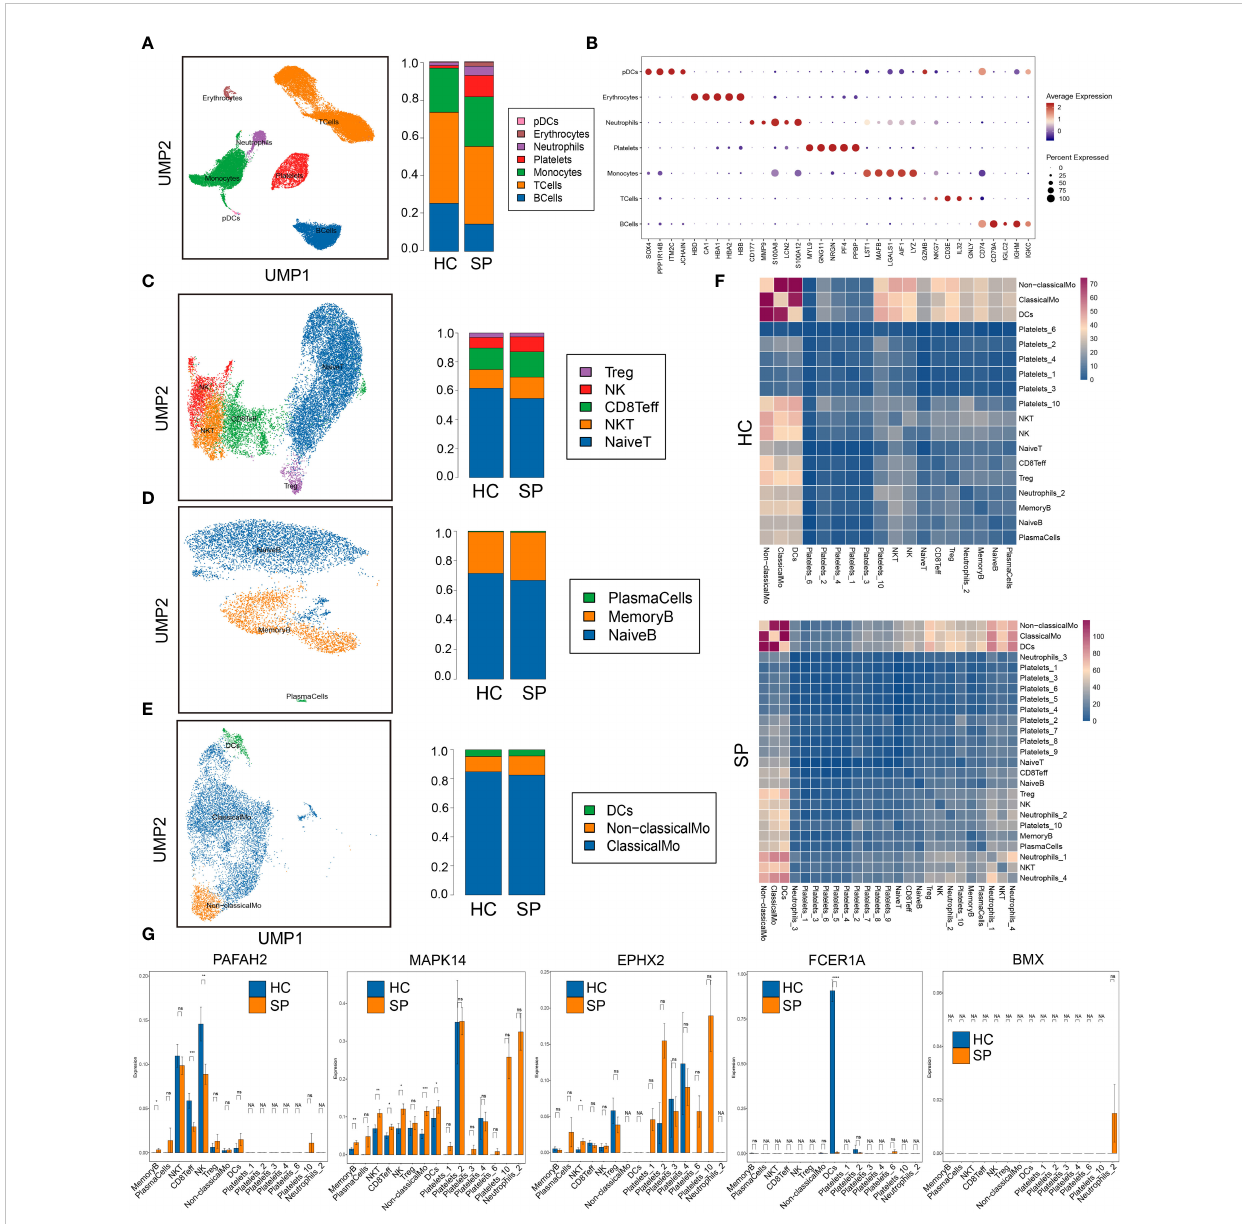
FIGURE 5 Single-cell gene expression analysis of peripheral blood mononuclear cells (PBMC) in sepsis. (A) UMAP plot of the cell clusters annotated by the SingleR package. (B) Bubble chart of the top fi ve markers of each cluster. (C) Subclusters of T cells. (D) Subclusters of B cells. (E) Subclusters of monocytes. (F) Heatmaps of number of ligand-receptor pairs across cell subgroups in HC and SP. (G) The expressions of the 5 hub genes in each subclusters. *: as compared with the Control group, P < 0.05; **: as compared with the Control group, P < 0.01; ***: as compared with the Control group, P <0.001; ****: as compared with the Control group, P <0.0001. ns: as compared with the Control group, no signi fi cant difference. NA: Not